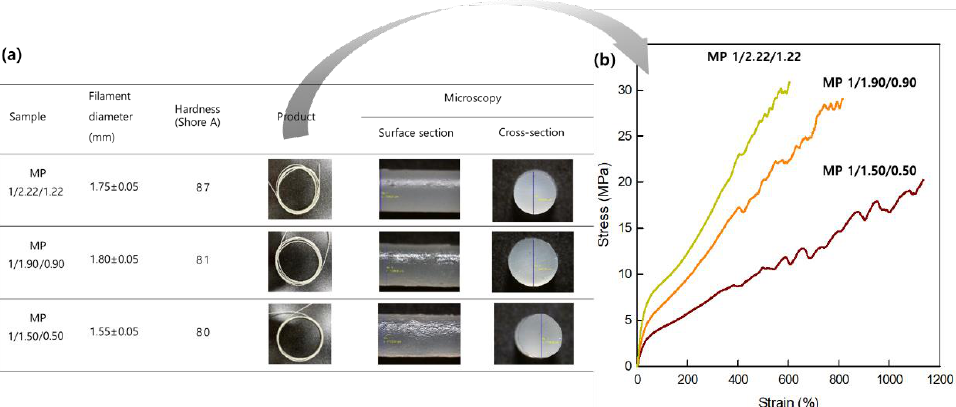
Figure 9. ( a ) Parameters and surface and cross-sectional images for the SMTPU filaments. ( b ) Tensile test curves for the prepared SMTPU